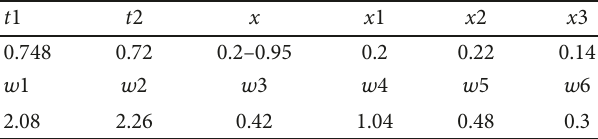
Table 2: Optimized dimensions for the waveguide-to-PCB transitions, and the phase shifter (all dimensions are in